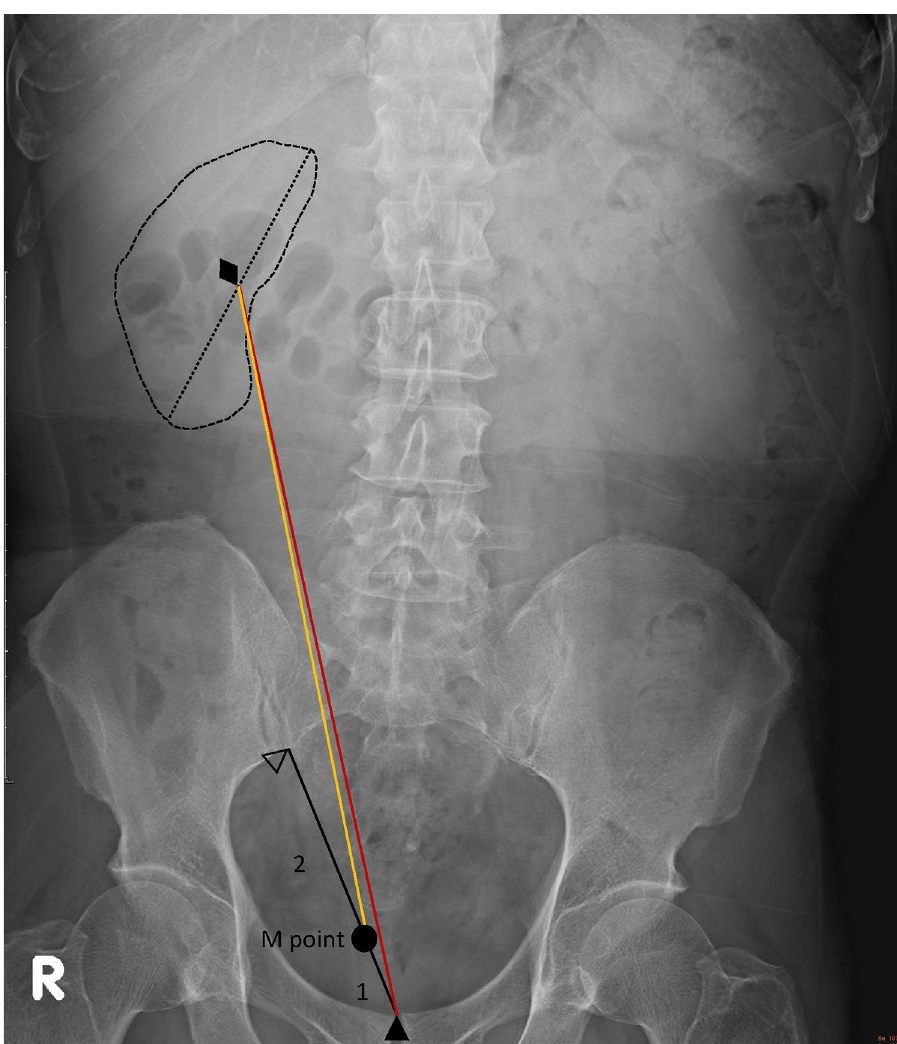
Figure 1. Measuring the length of C-P and C-PS. We took the point landing on the line from midpoint of superior margin of the pubic symphysis to the lower point of sacroiliac joint (P-S) as M point. M point was on one third the length of P-S closer to superior margin of pubic symphysis. C-PS was the length from central kidney point to M point. C-P was the length from central kidney point to superior margin of pubic symphysis. ♦ : The central kidney point, defined as the midpoint of the long axis of kidney. ∆: The lower point of sacroiliac joint. ▲ : The midpoint of superior margin of the pubic